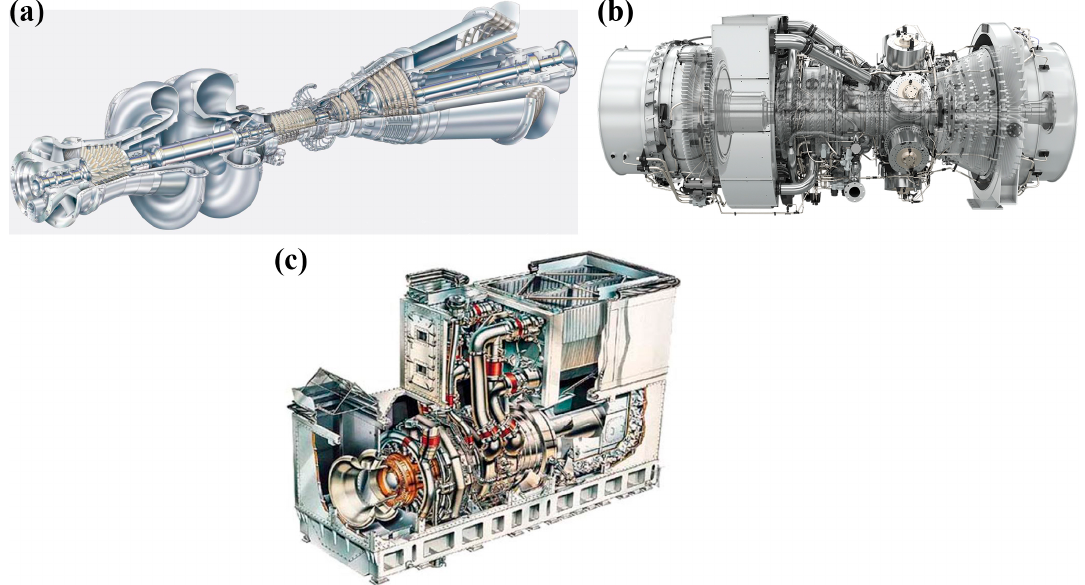
Figure 2. Gas turbine engines containing intercoolers, where ( a ) shows the General Electric LMS 100 engine, ( b ) demonstrates the Siemens SGT-A65 engine, and ( c ) illustrates the Westinghouse and Rolls-Royce WR-21 engine [17,18].